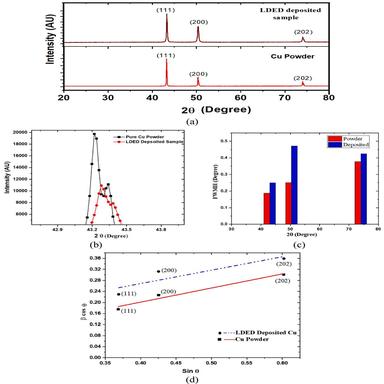
XRD a) Pattern b) Peak-shift c) FWHM d) Williamson-Hall plot.